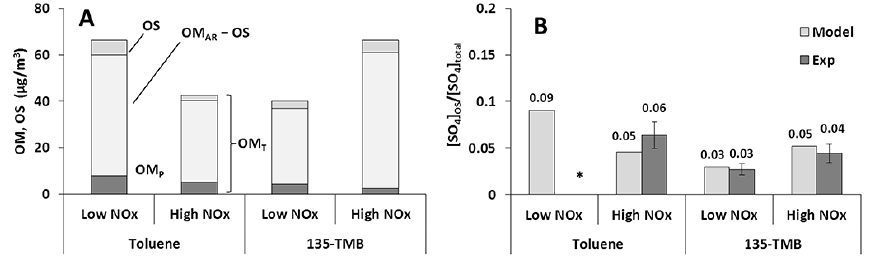
Fig. 4. Model-predicted fractions of OM P , OM AR , and OS of the total SOA for toluene SOA and 135-TMB SOA under two NO x levels (low and high) (Experiments 1–8 in Table 1) (A) . Comparison of the OS fraction of the total sulfate between model prediction and measurement using the C-RUV method and PILS-IC (B) .The uncertainty associated with the ratio of OS to total sulfate is determined based on uncertainties of C-RUV (about 10%) and PILS-IC measurements (about 10%) by the propagation of uncertainty (Ku, 1966). ∗ No experimental data are